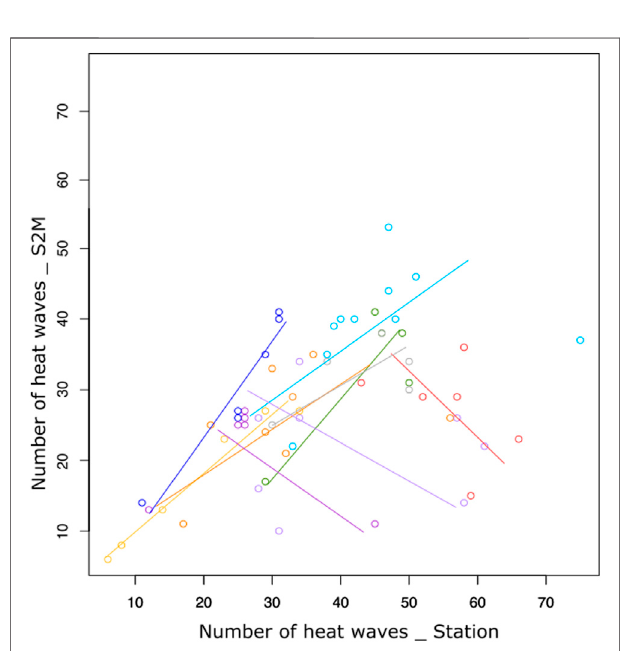
FIGURE 5 | Number of days of heat waves calculated from stations and S2M foreach station (colors) having at least fi vesummerswithcomplete data.